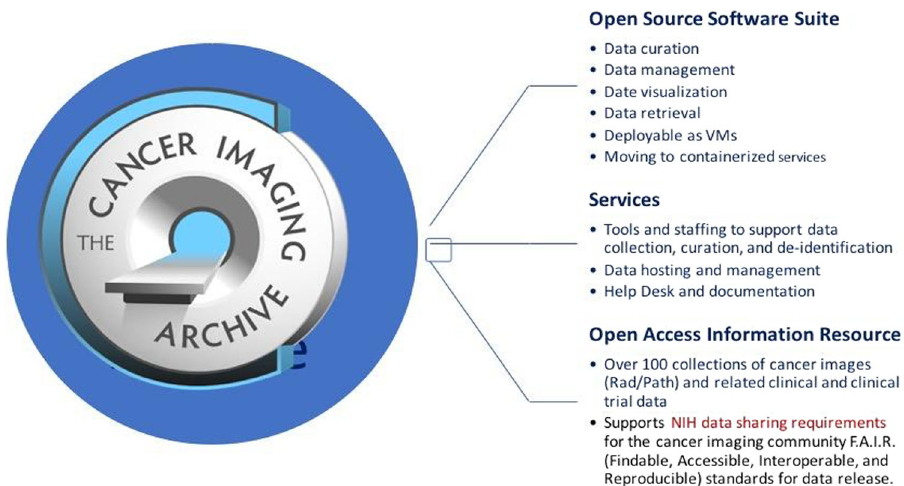
Fig. 6 The Cancer Imaging Archive (TCIA) is a system of systems constructed from open-source software. TCIA is also a set of services designed to collect and curate high quality cancer image data and related clinical data and make it publicly available. (VMs =